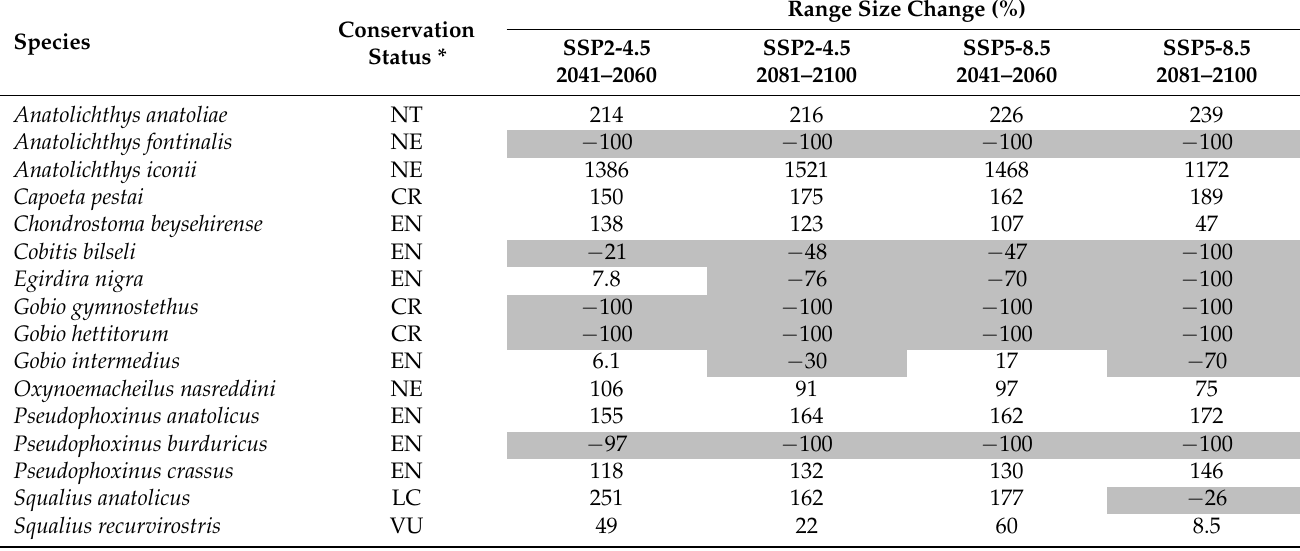
Table 2. Conservation status [80] of the endemic freshwater fishes of the CAE and changes in their distribution range for various future climate scenarios and periods (grey shaded areas indicate the predicted losses in species distribution